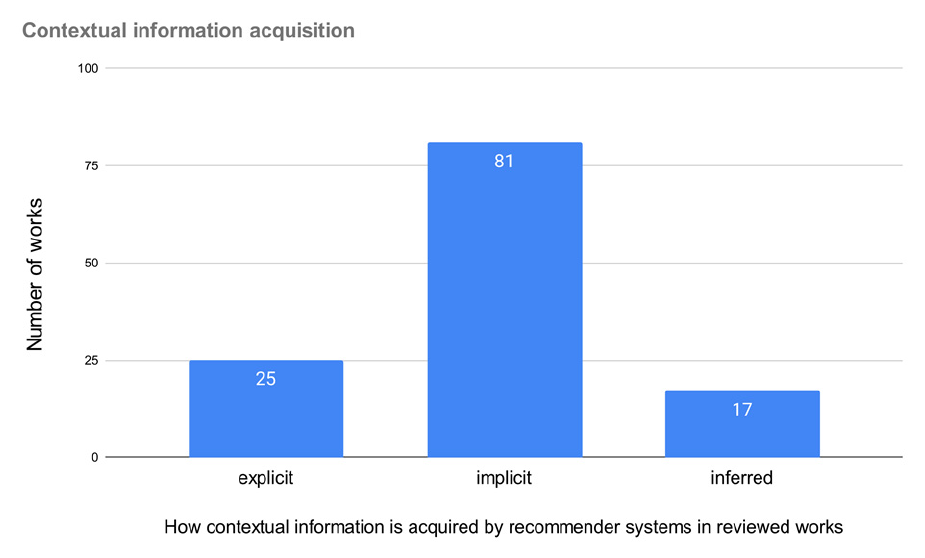
Figure 2. How contextual information is acquired by recommender systems in reviewed works. Table 2. Context classification of included